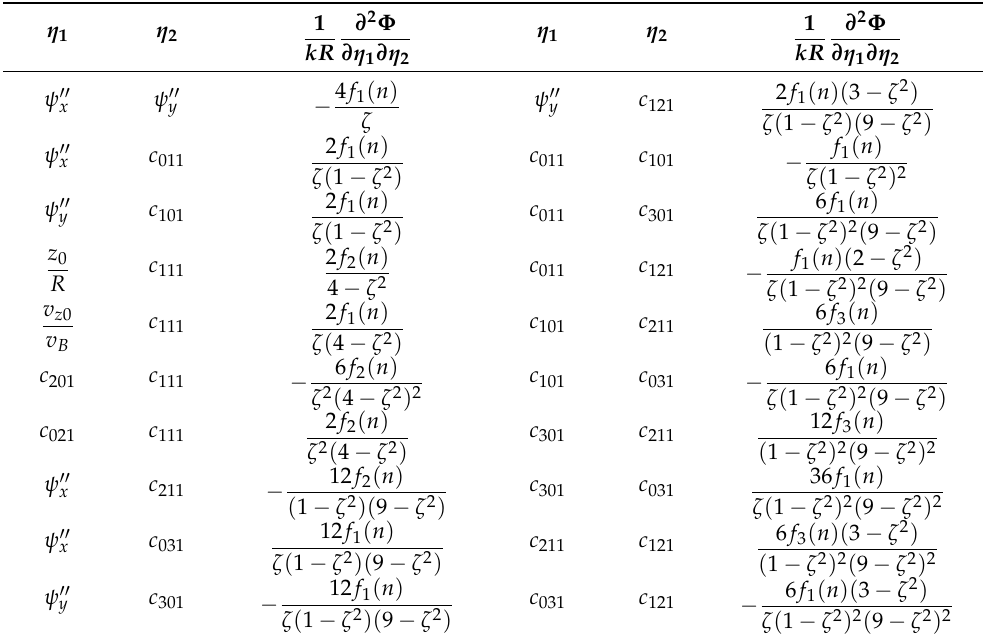
Table 2. Phase sensitivity for a cylindrically symmetric trap with ω z = ζω . Terms below the horizontal line in the second column are those that that differ from their values in the spherically symmetric case of Table 1. Other terms from Table 1 apply without change. Terms in the first column and above the line are those that appear only in the cylindrical case. The dependence on ζ and on the number of orbits n are determined numerically. The n -dependence is parametrized by the functions f 1 ( n ) = sin2 πζ ( n + 1/4 ) sin πζ /2, f 2 ( n ) = cos2 πζ ( n + 1/4 ) cos πζ /2, and − − cos ( 2 πζ n ) f 3 ( n ) = 1 −